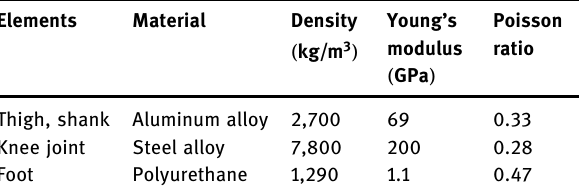
Table 2: Material properties of each element model Elements